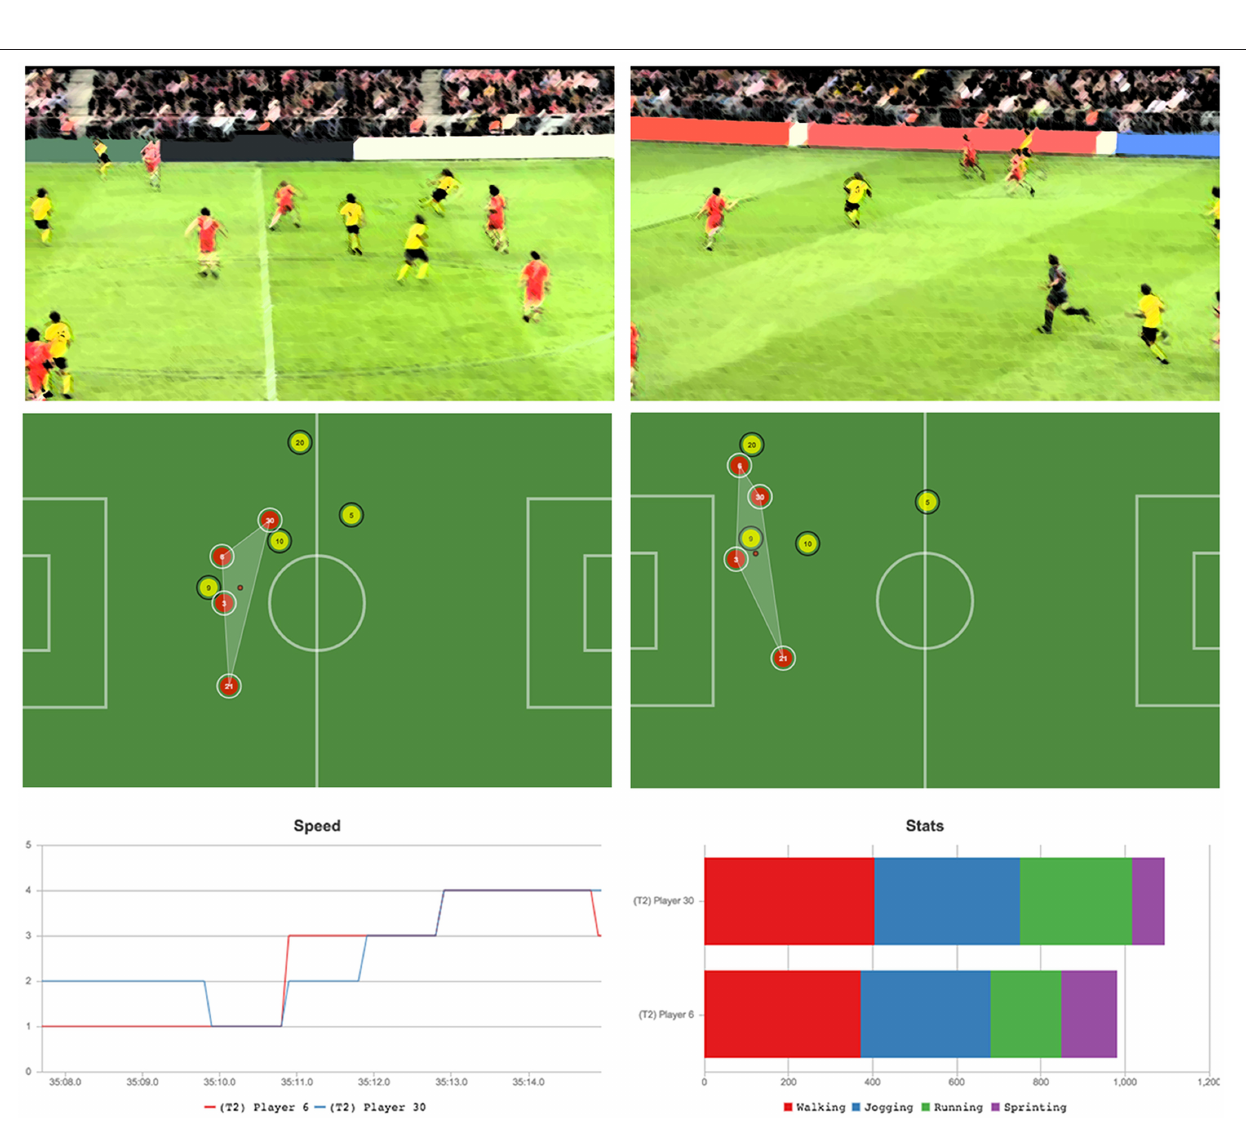
the line graph, without the need to visualize the entire 6 min of